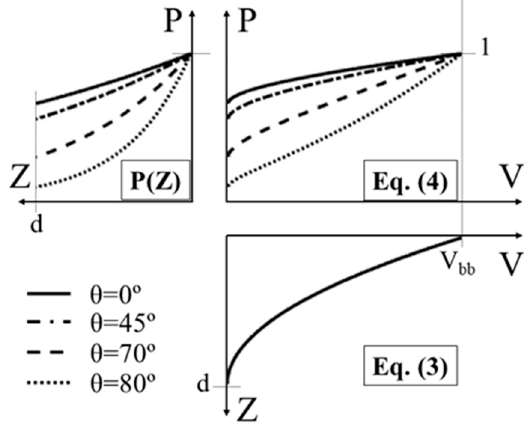
Figure 2. Functions resume for the generation of a band bending contribution: P ( Z ) is the inelastic electron escape probability (see Equation (1)) for λ = 2.4 nm and θ = 0°, 45°, 70°, and 80°. Equation (3) is the potential curvature obtained from the Poisson’s equation solution based on the Schottky approximation for V 0 = 0, band bending maximum potential V bb , and band bending width d . Equation (4) is obtained by substitution of z in Equation (3) into P ( z ). It must be noticed that, in the XPS spectrum, a downward band bending is seen toward higher binding energy (B.E.).